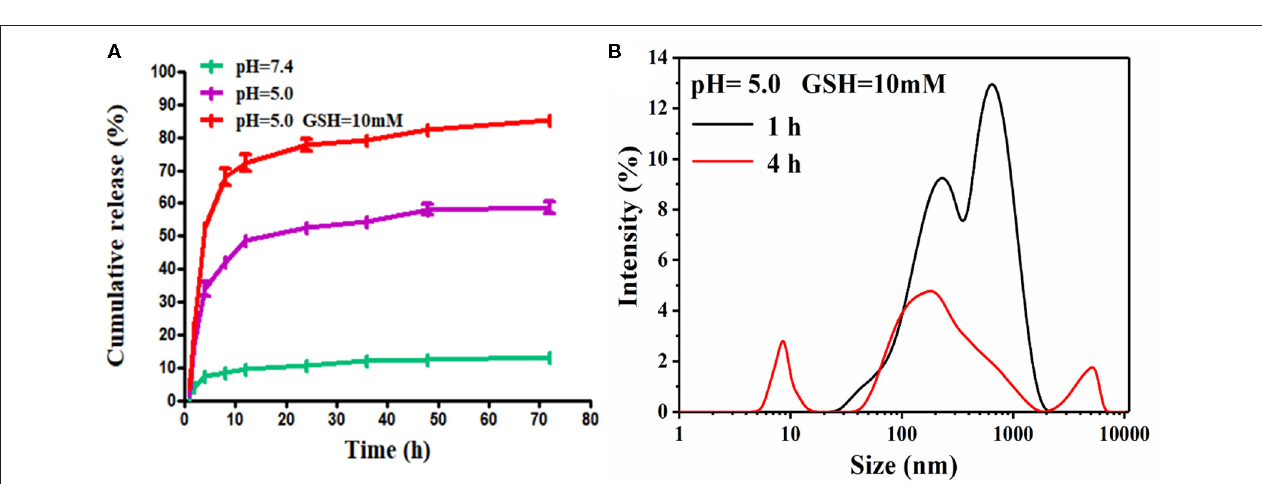
FIGURE 4 | pH and redox dual sensitiveness of HY/SS-CONs. (A) Drug release profiles of DOX-loaded HY/SS-CONs under PBS 7.4, PBS pH 5.0, and PBS pH 5.0 with 10mM GSH; (B) Size changes of HY/SS-CONs incubated at pH 5.0 with 10mM GSH for different time.